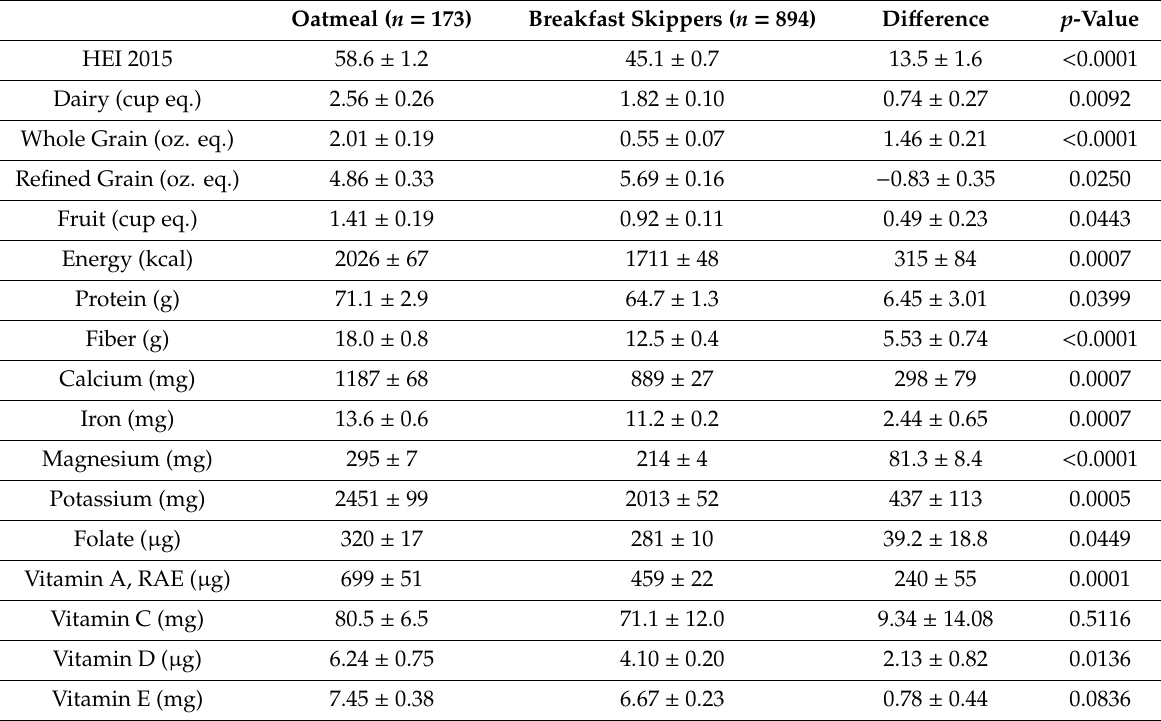
Table 2. Comparison of diet quality and intake of select food groups and nutrients for children 2–18 years of age (gender-combined), who consumed oatmeal breakfasts and those who skipped breakfast, NHANES